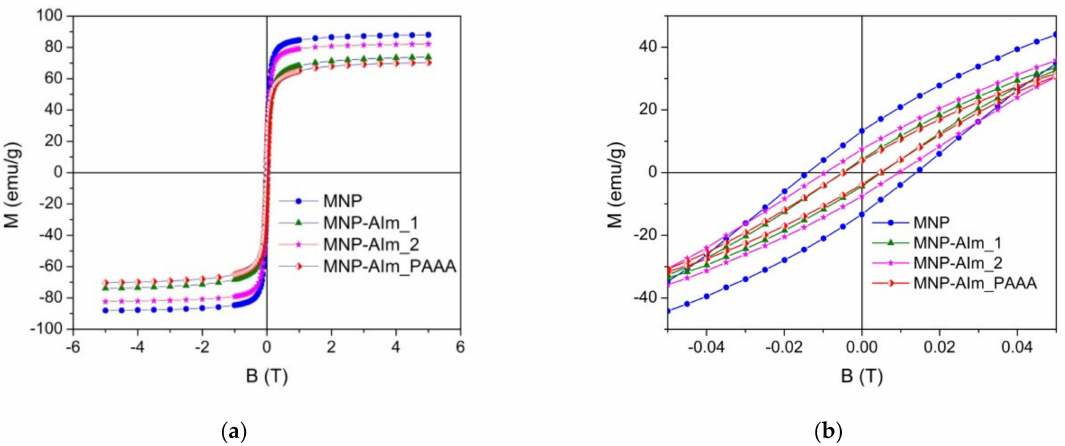
Figure 11. The magnetization ( a ) vs. applied magnetic field ( b ) of uncoated MNP and magnetic nanostructures MNP-AIm_1, MNP-AIm_2 and MNP-AIm_PAAA at room